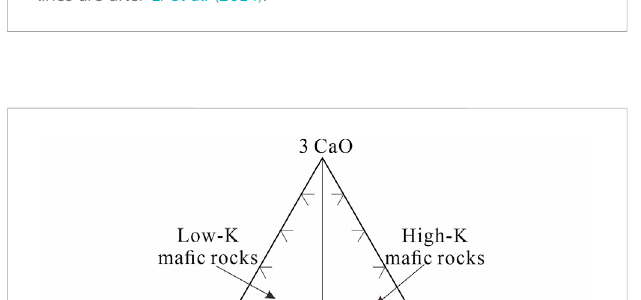
FIGURE 13 t ) versus t diagram of zircons from BHSG. The data of the ε Hf ( ShuangqiaoshanGrouparefromWangetal.,2008.Thecrustalevolution lines are after Li et al. (2014).